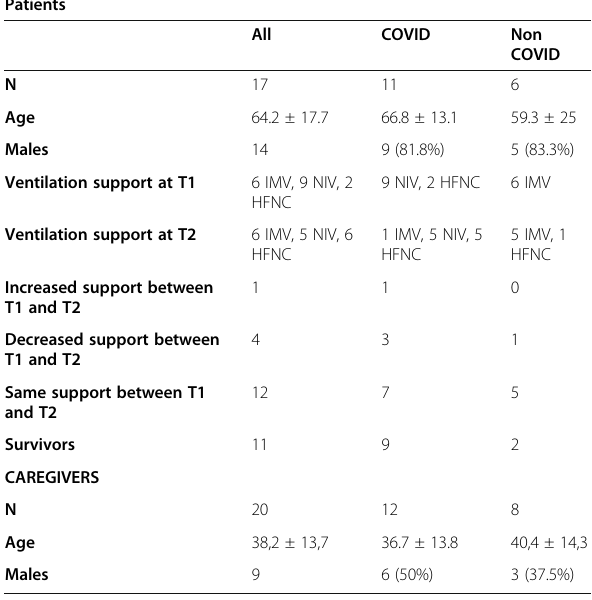
Table 1 (abstract A125). Demographics of patients and caregivers Patients